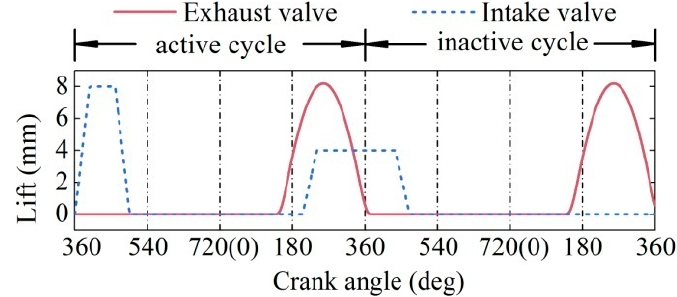
Figure 6. The schematic of the valve strategy based on exhaust gas trapping.